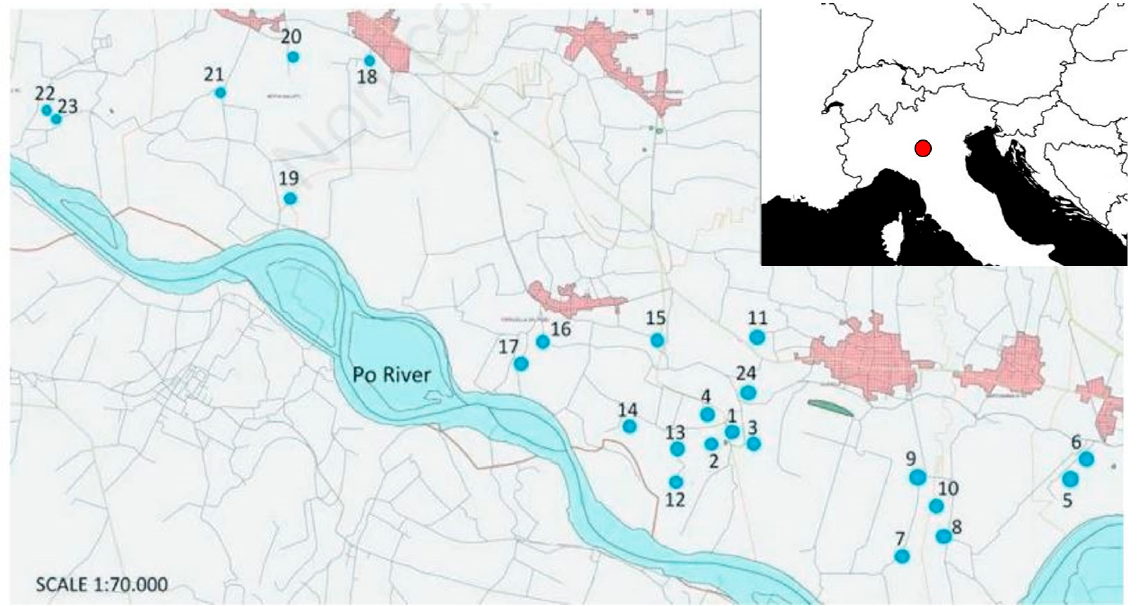
Figure 1. The map reports the position of the 24 ponds (Table S1), located along the left hydrographyc bank of the Po River, in the Cremona province (North Italy).